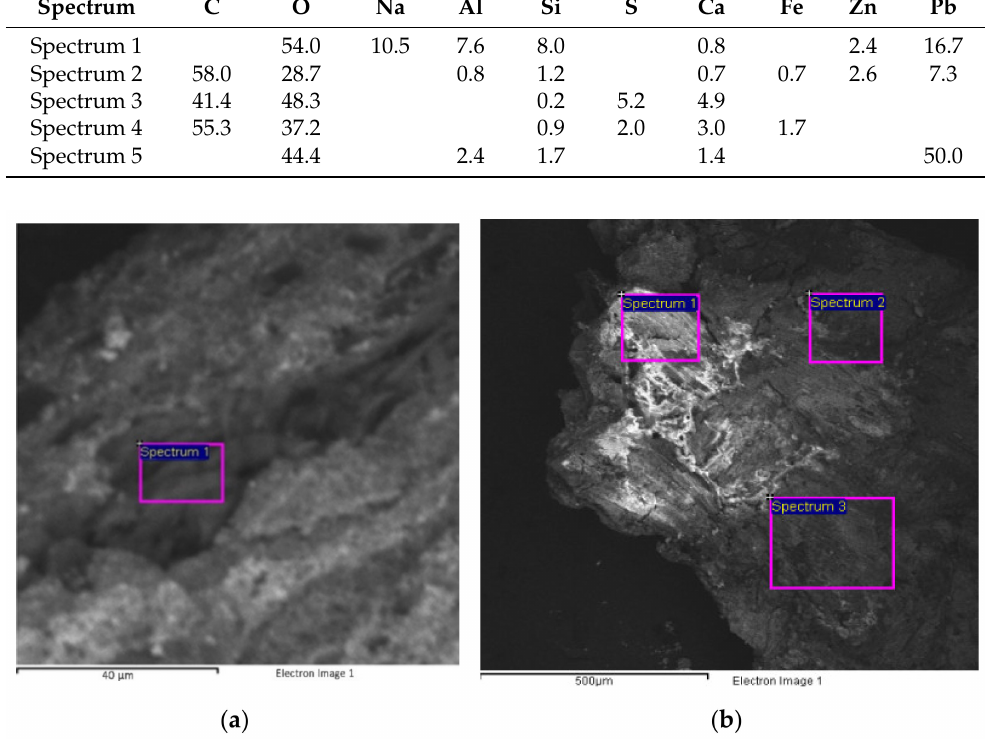
Figure 6. SEM images showing other details of sample 1. Image of the crystal-like dark contrasting area corresponding to the first paint layer ( a ) with the indication of the analyzed areas corresponding to the results in Table 3. Image of the paint layers ( b ) with the indication of the analyzed areas corresponding to the results in Table